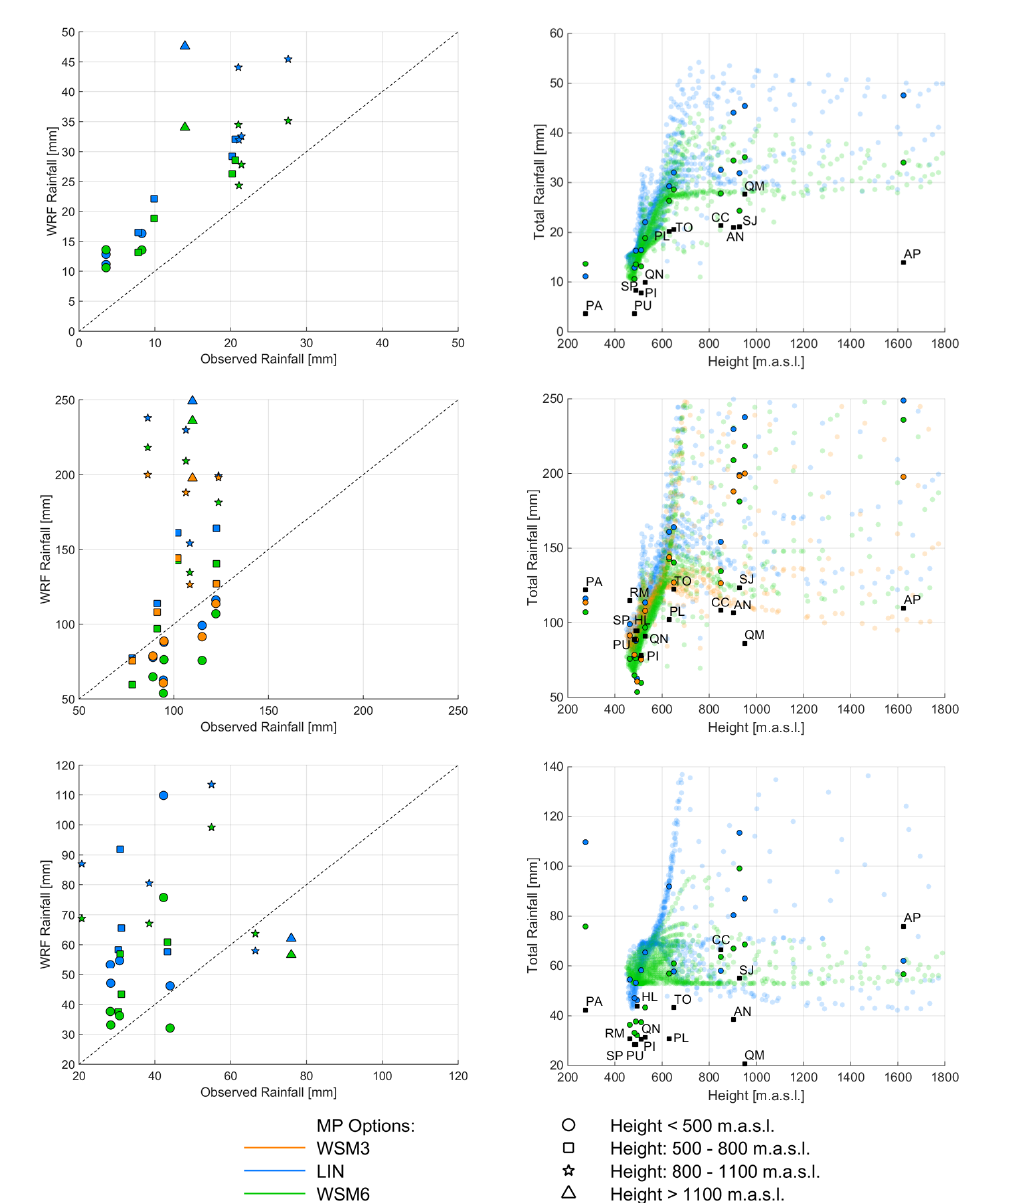
Figure 4. Total observed and simulated precipitation according to height ( left ) and orographical gradient ( right ) for OCT15 ( upper row), APR16 ( central row) and MAY17 ( lower row) events. The mean value of all lead times (72, 96 and 120 h) and three MP parameterizations (LIN, WSM6 and WSM3 when used) are considered. In right panels, observed data are plotted in black